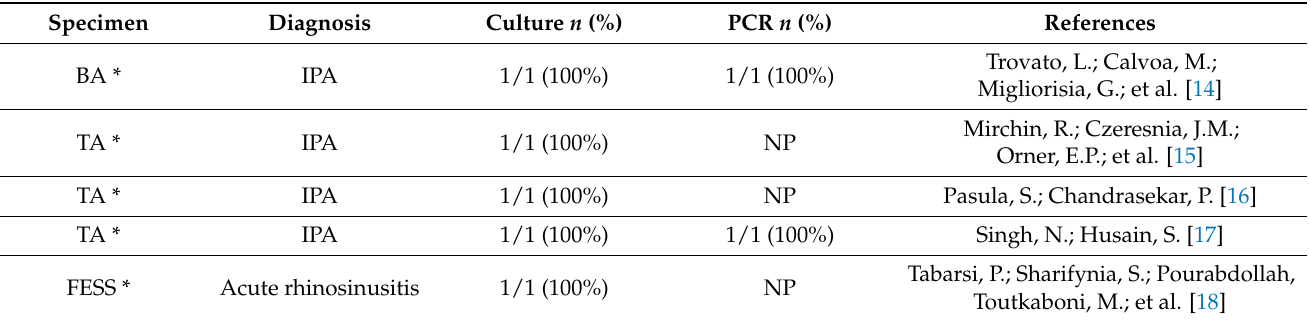
Table 1. Review of literature on the detection of Aspergillus niger